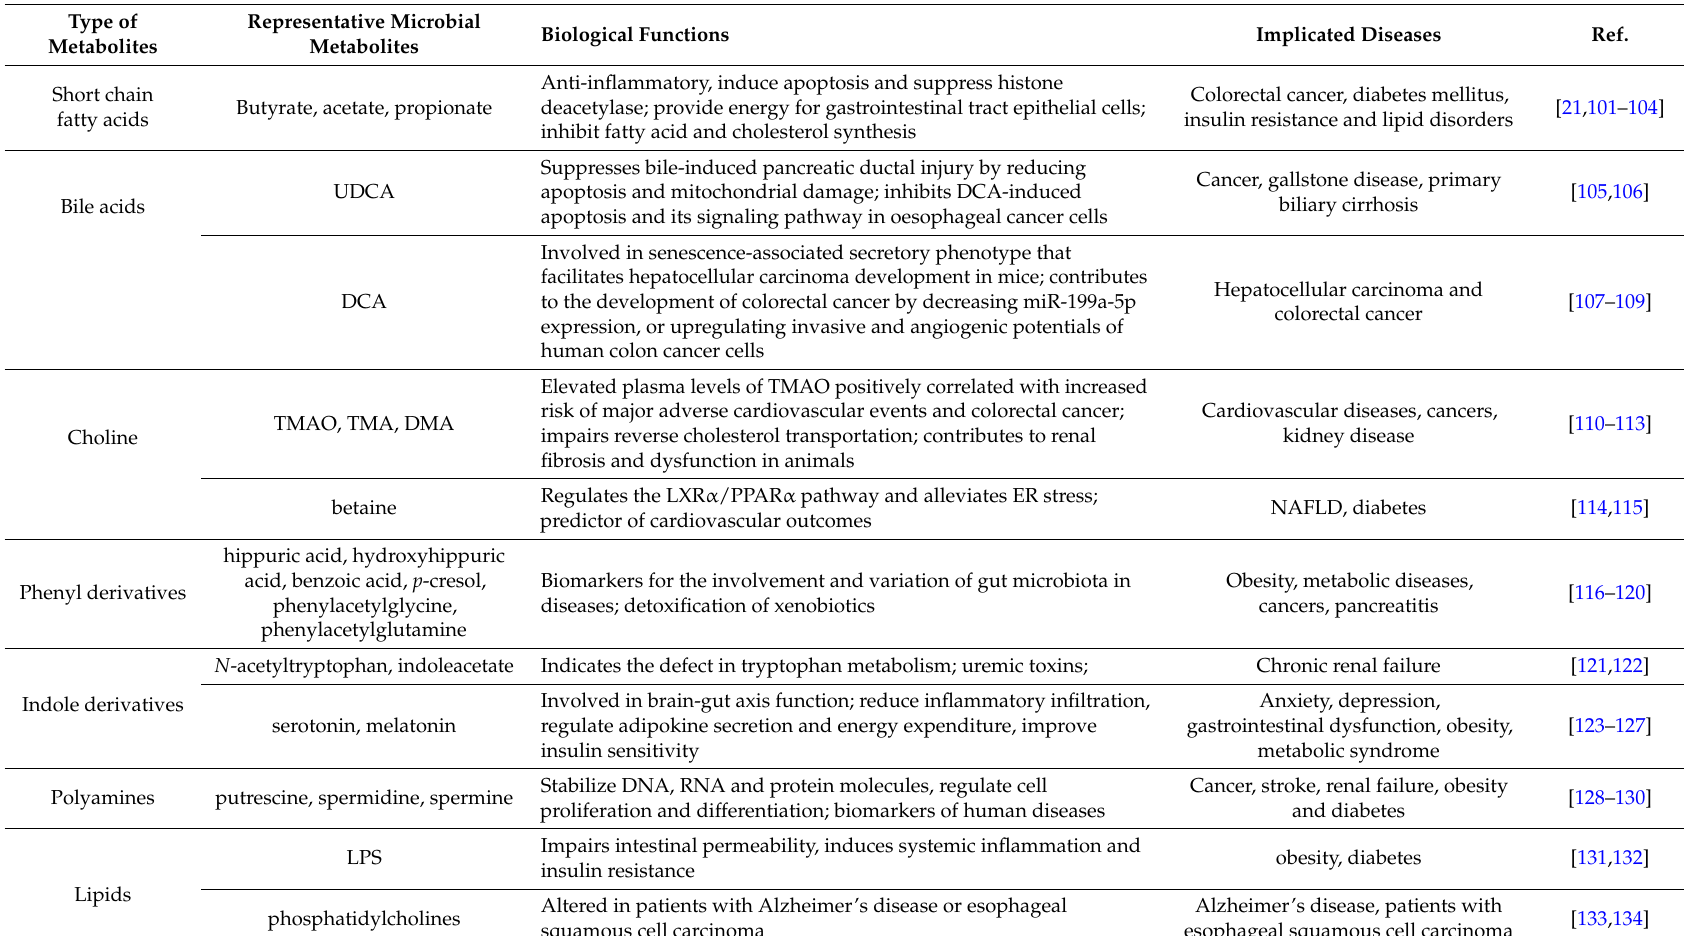
Table 1. Microbial metabolites and their implicated